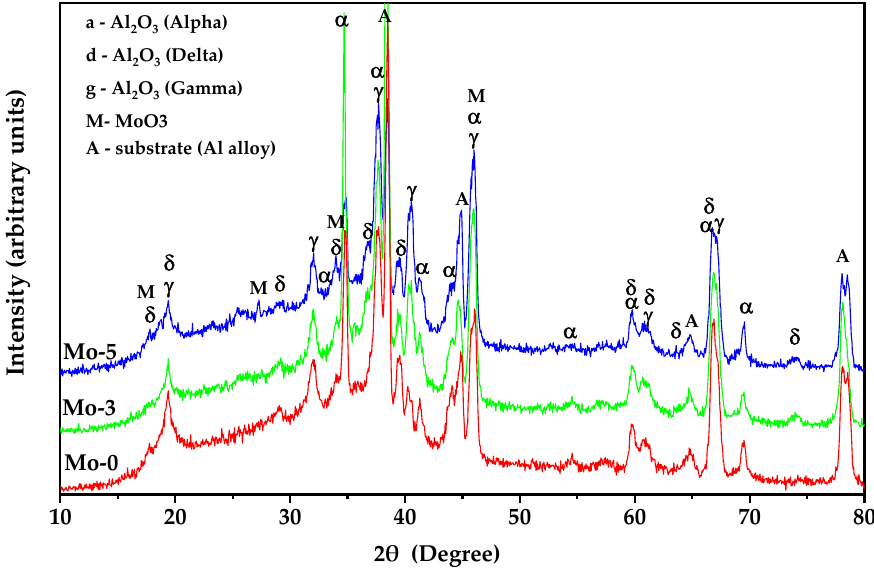
Figure 7. XRD patterns of the PEO coatings grown at various Na 2 MoO 4 concentrations.